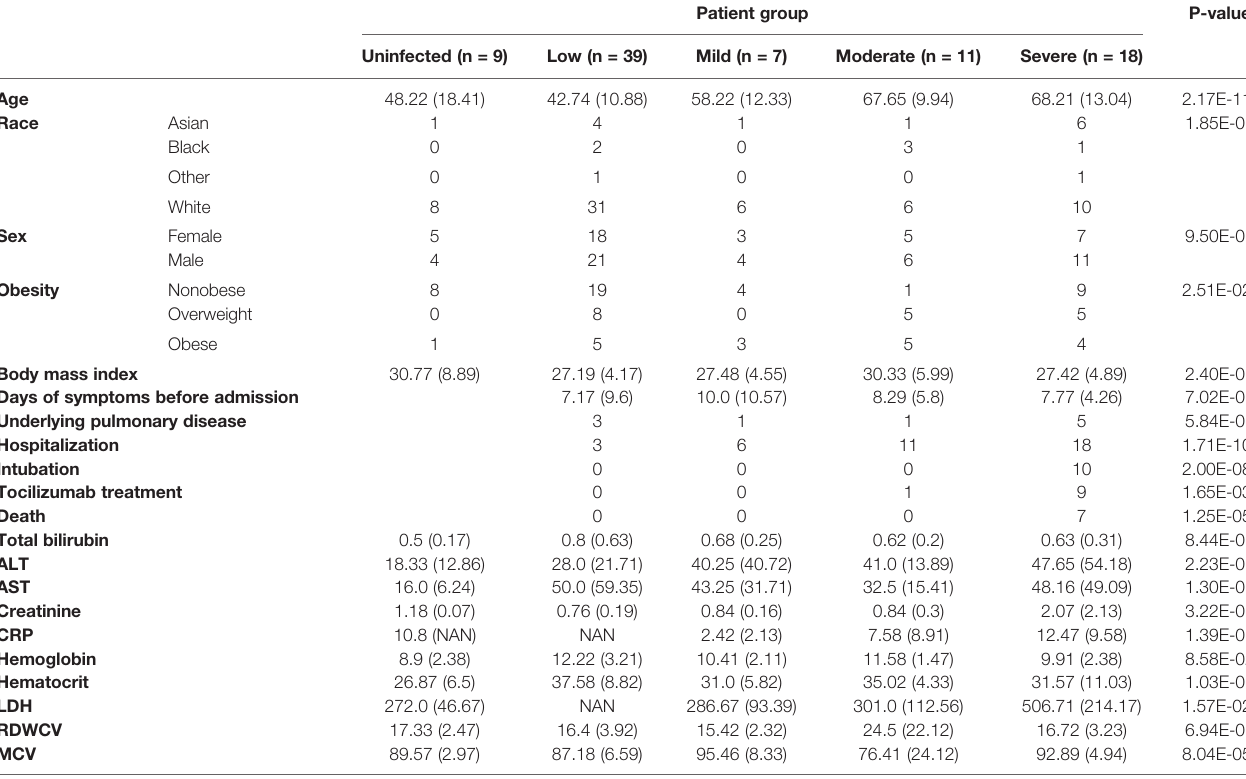
TABLE 1 | Demographic and clinical characteristics of the cohort.